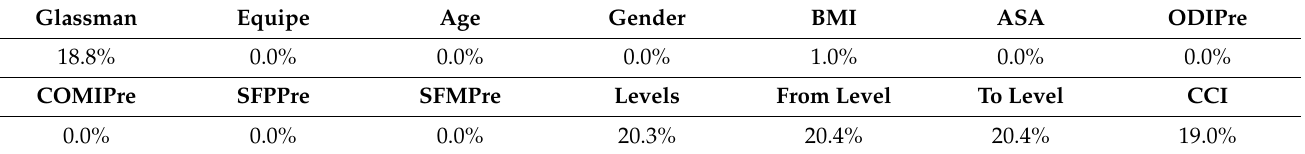
Table 1. Table with the features included in the analysis and associated percentage of missing values.